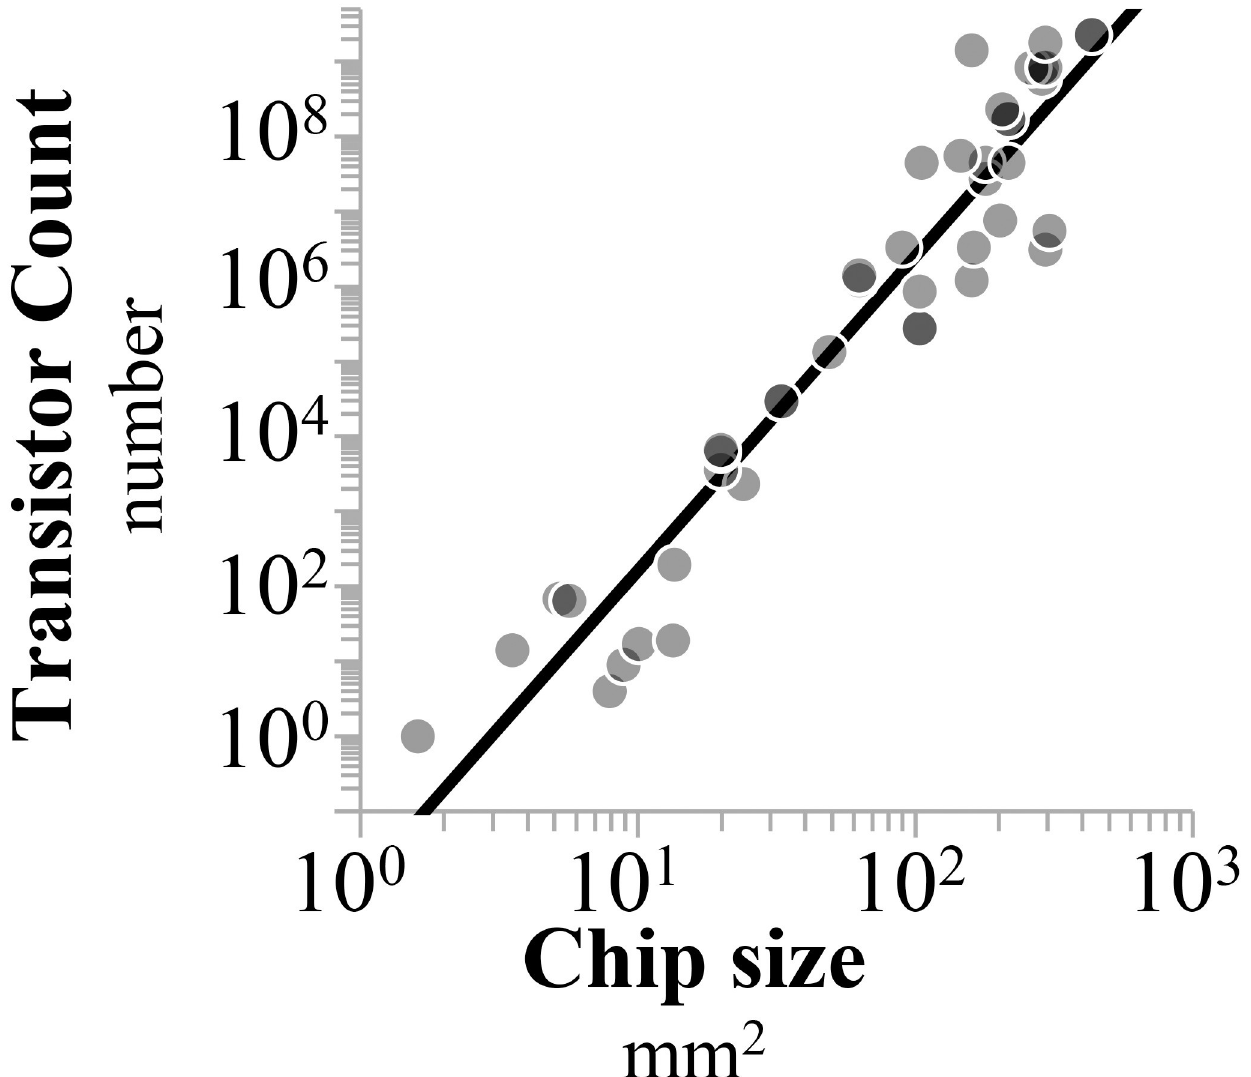
Fig 2. A power-law relationship between state-of-the-art processor size and the number of transistors ( T / A 4.4 , P < 0.001).